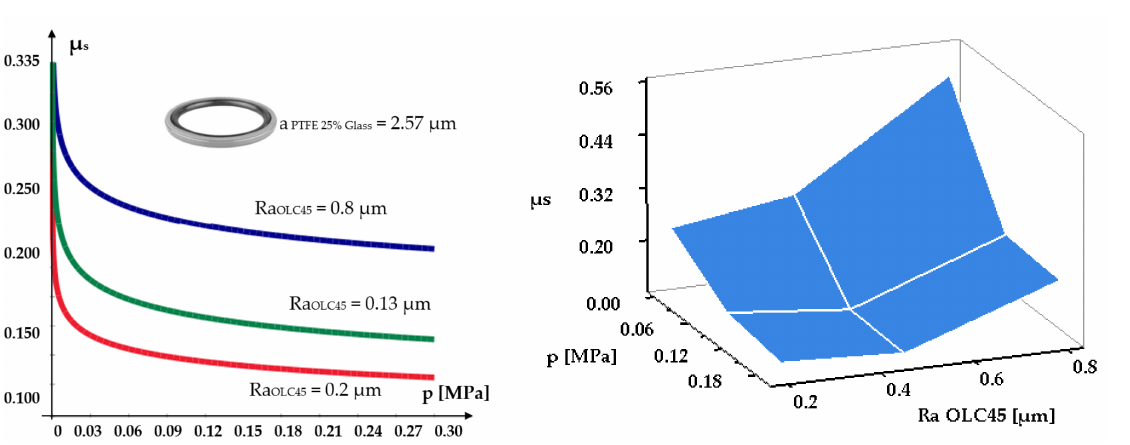
Figure 4. Dependency of the static friction coefficient on contact pressure and surface roughness for the material pair OLC45/Virgin PTFE.